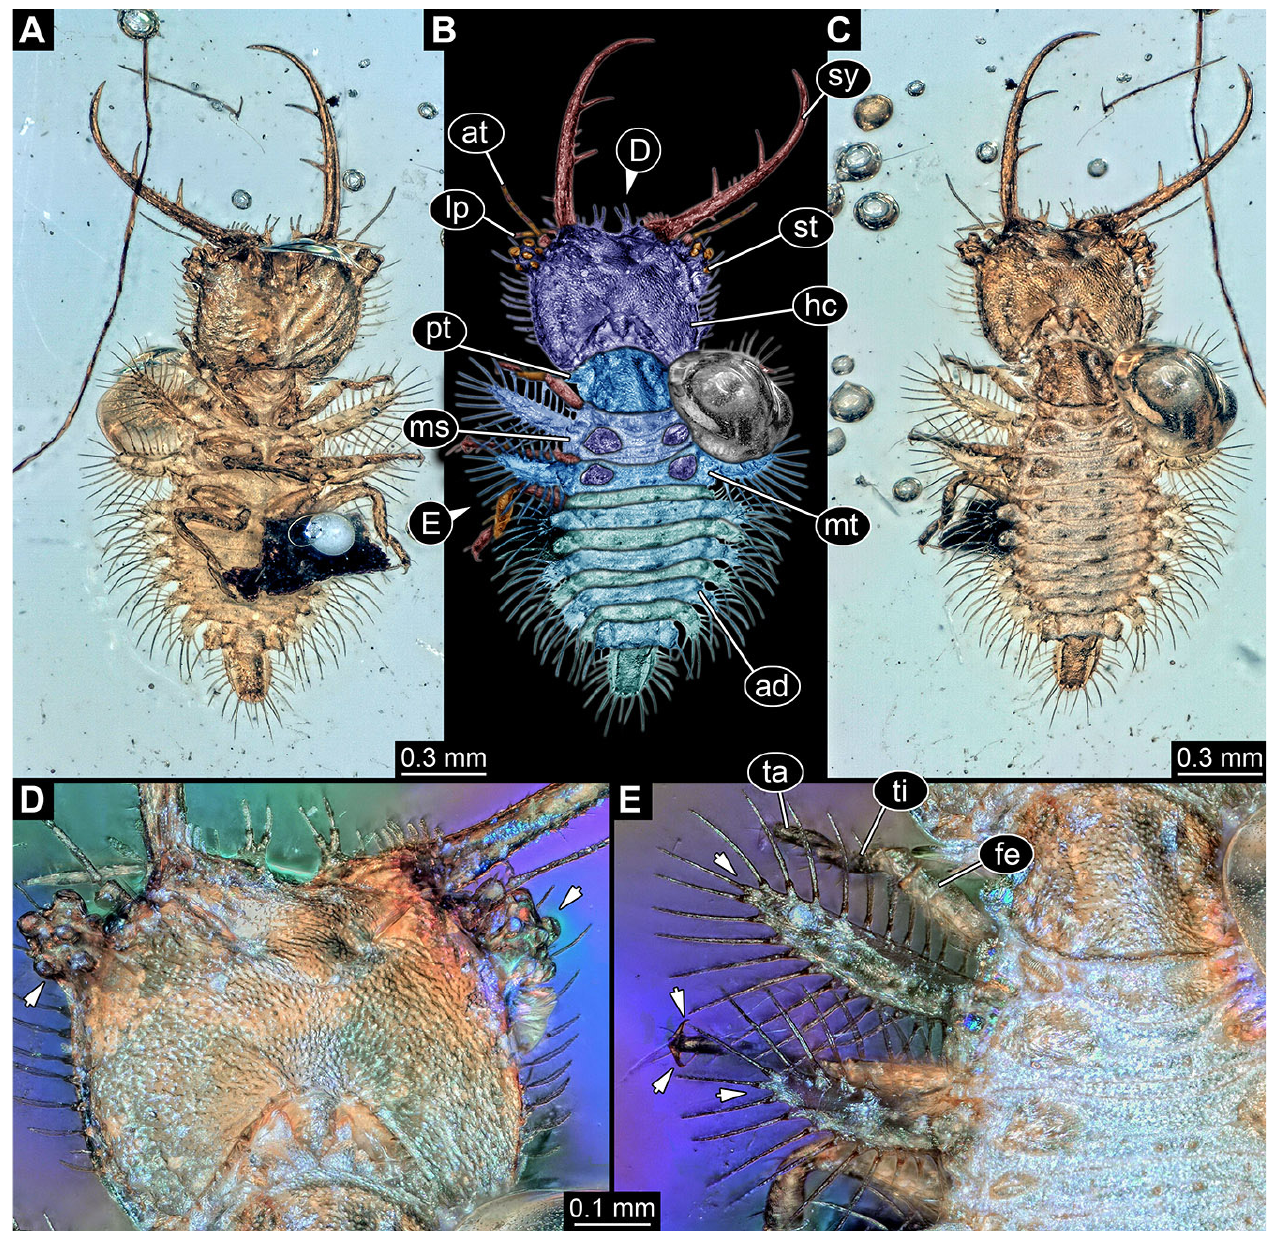
Figure 4. Fossil owllion larva, specimen 3215 (BUB 2537), Cretaceous Kachin amber, Myanmar. ( A ) Overview, ventral. ( B ) Color-marked version of ( C ). ( C ) Overview, dorsal. ( D ) Close-up on head capsule with fields of stemmata (arrows). ( E ) Close up on anterior trunk region with locomotory appendages with distal claws (two middle arrows) and dorsal processes (upper and lower arrow). Abbreviations: ad = abdomen; at = antenna; fe = femur; hc = head capsule; lp = labial palp; ms = mesothorax; mt = metathorax; pt = prothorax; st = stemmata; sy = stylet; ta = tarsus; ti = tibia.